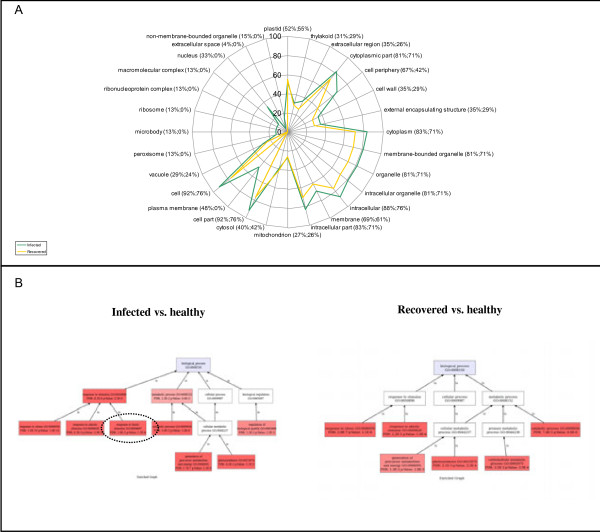
GO classification and GO enrichment analysis of differentially expressed proteins in infected and recovered plants. A) Cellular component term assignment and distribution. B) Biological process term assignment and distribution. The statistical significance of the Enrichment Analysis is represented by a scale of red tones whose intensity is proportional to the degree of significance starting from FDR ≤ 0.05.